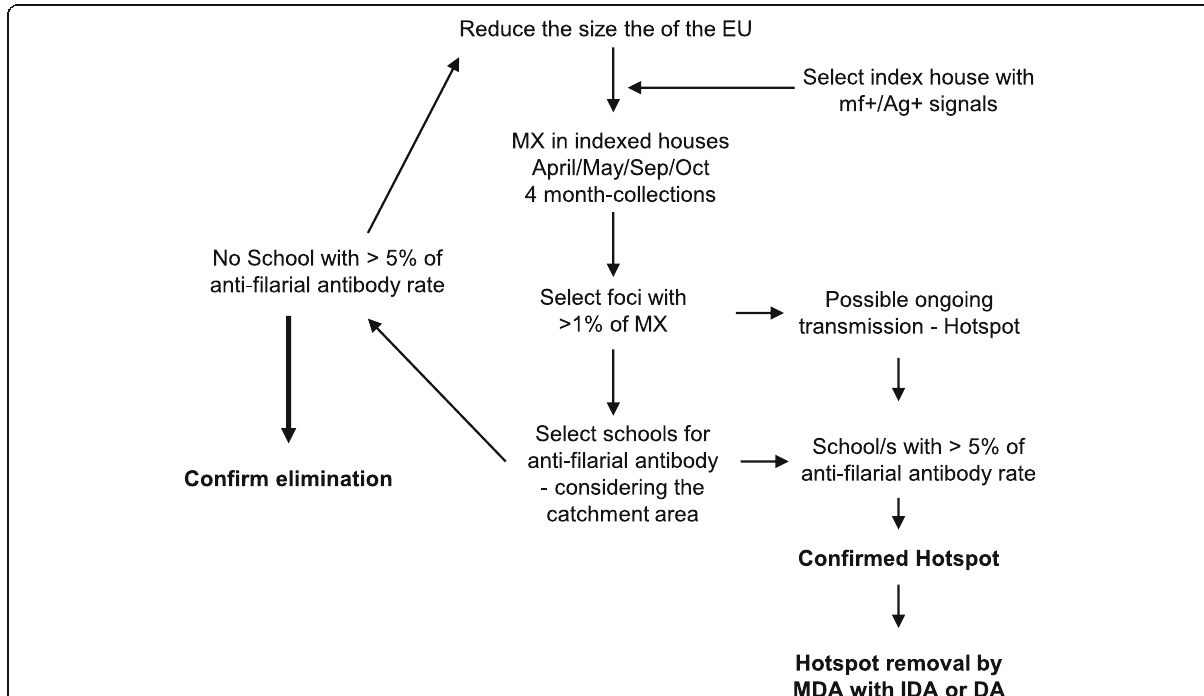
Fig. 4 A convenient epidemiological approach to find hotspots of LF transmission and action plan for hotspot removal in Sri Lanka. EU evaluation units; mf +/ Ag + microfilaria positive and/or filarial antigen positive; MX molecular xenomonitoring; MDA mass drug administration; IDA a combination of ivermectin, diethylcarbamazine, and albendazole; DA a combination of diethylcarbamazine and